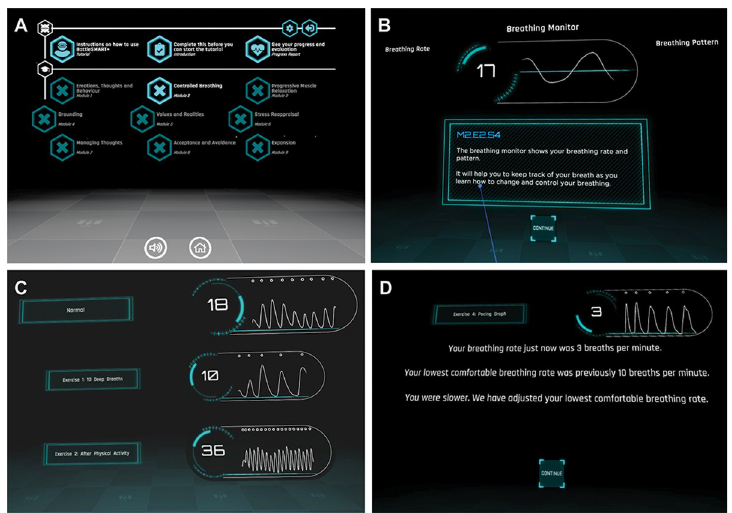
Fig 2. Screenshots and key features of Performance Edge VR. A) Screenshot of the main menu design, which provides access to 3 overview items (top) and 9 training modules (bottom). The main menu can be accessed at